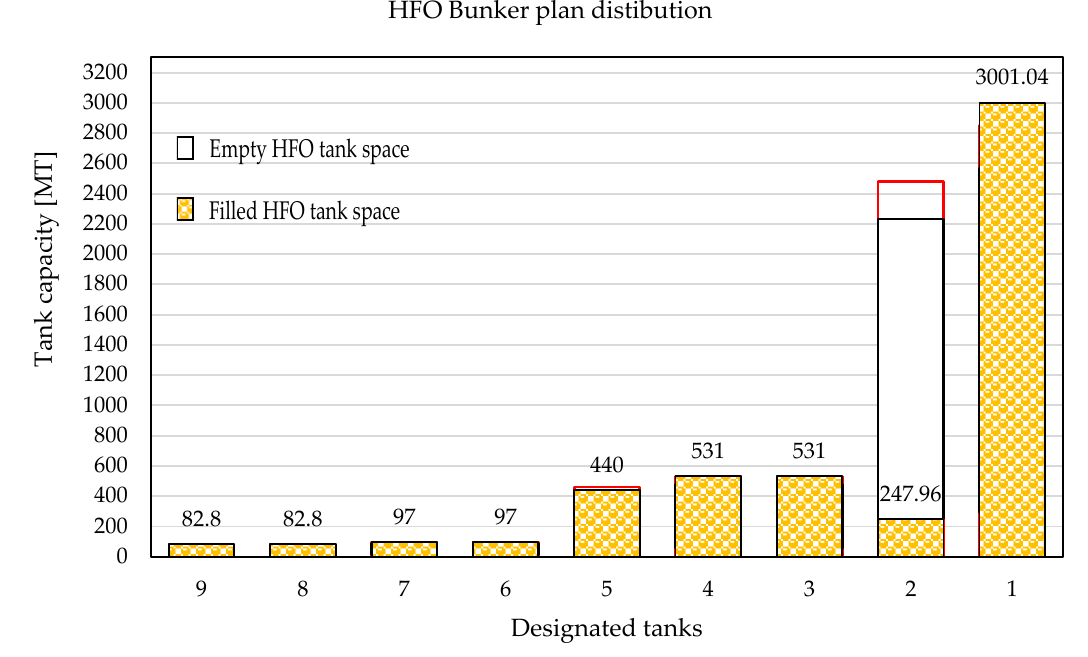
Figure 8. HFO bunker condition before bunker loading for the third example.